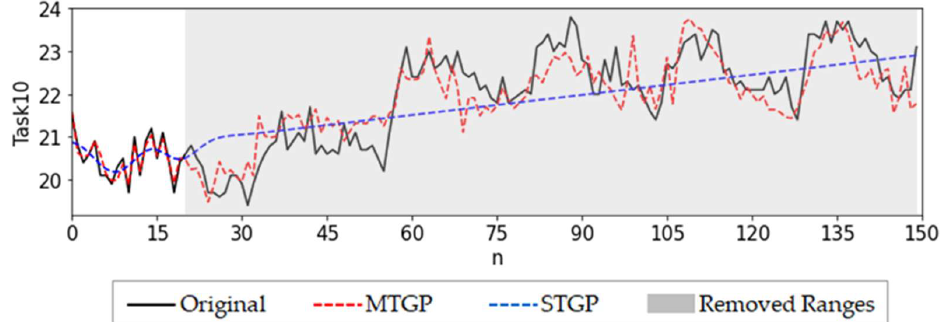
Figure 10. Imputation results of MTGP and STGP for the extreme situation.